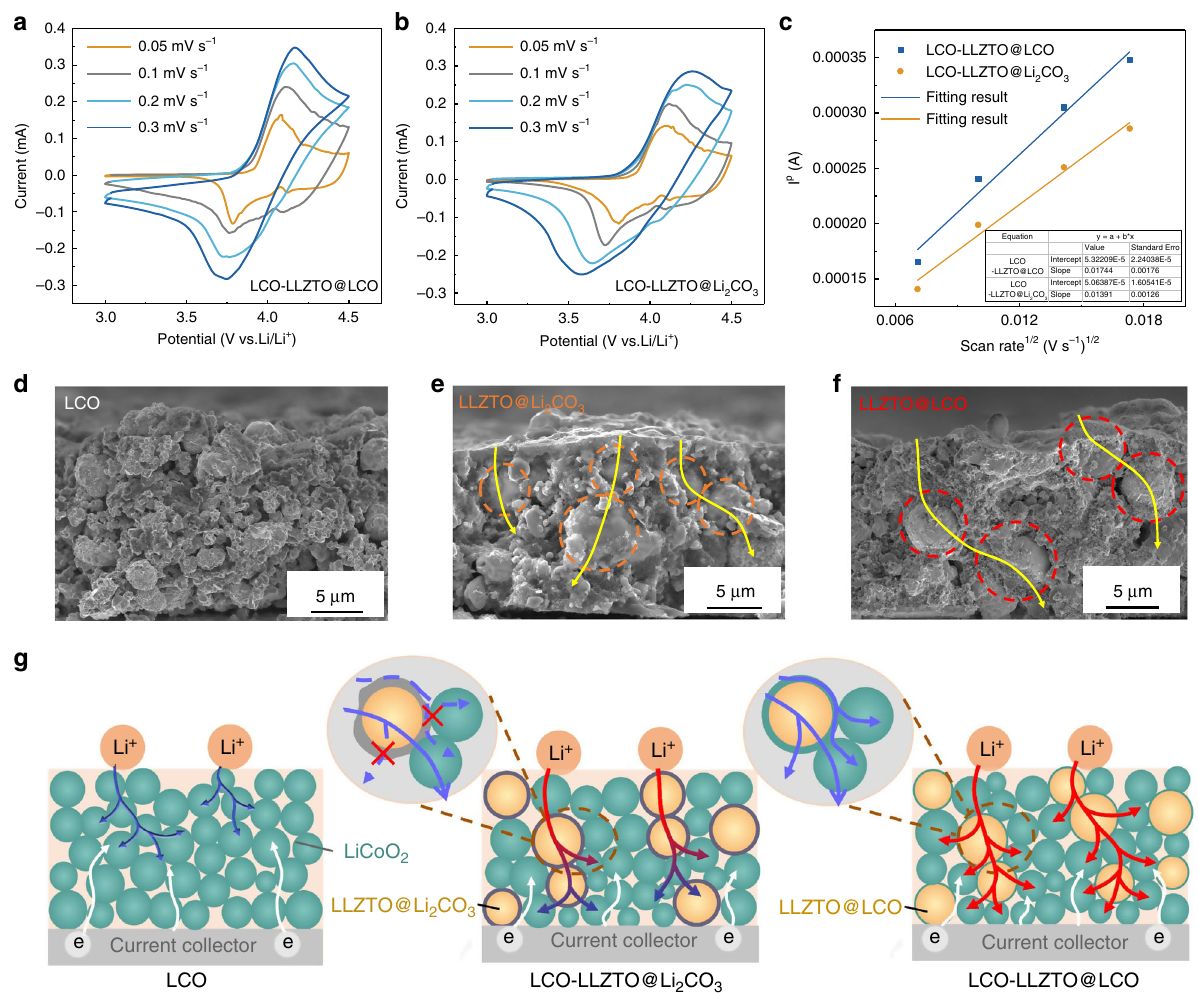
Fig. 4 Characterization and ionic transport mechanism of the cathodes. CV pro fi les of a LCO-LLZTO@LCO and b LCO-LLZTO@Li 2 CO 3 cathodes at different scan rates. c Peak current as a function of the square root of the scan rate of LCO-LLZTO@LCO and LCO-LLZTO@Li 2 CO 3 cathodes. d – f Cross- sectional SEM images of the LiCoO 2 , LCO-LLZTO@Li 2 CO 3 and LCO-LLZTO@LCO cathodes, separately. g Schematic illustration of the ionic transport mechanism inside